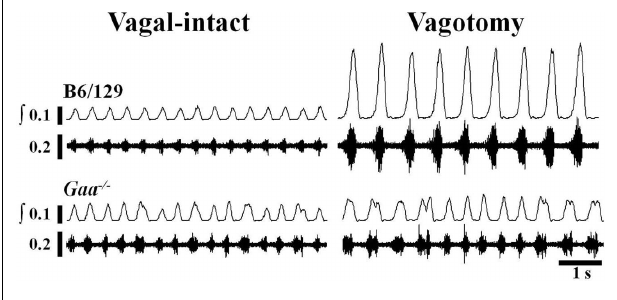
FIGURE 3 | Examples of efferent XII nerve activity in B6/129 and Gaa − / − mice under vagal-intact and vagotomized conditions. Both (cid:2) “raw” and integrated ( ) neurograms are shown. In the vagal-intact condition, the amplitude of the XII signal is similar between the two mice, but the Gaa − / − mouse shows more variability in the timing of the respiratory cycle. Following bilateral cervical vagotomy there is a robust increase in XII burst amplitude in the B6/129 mouse whereas the Gaa − / − mouse shows little change.